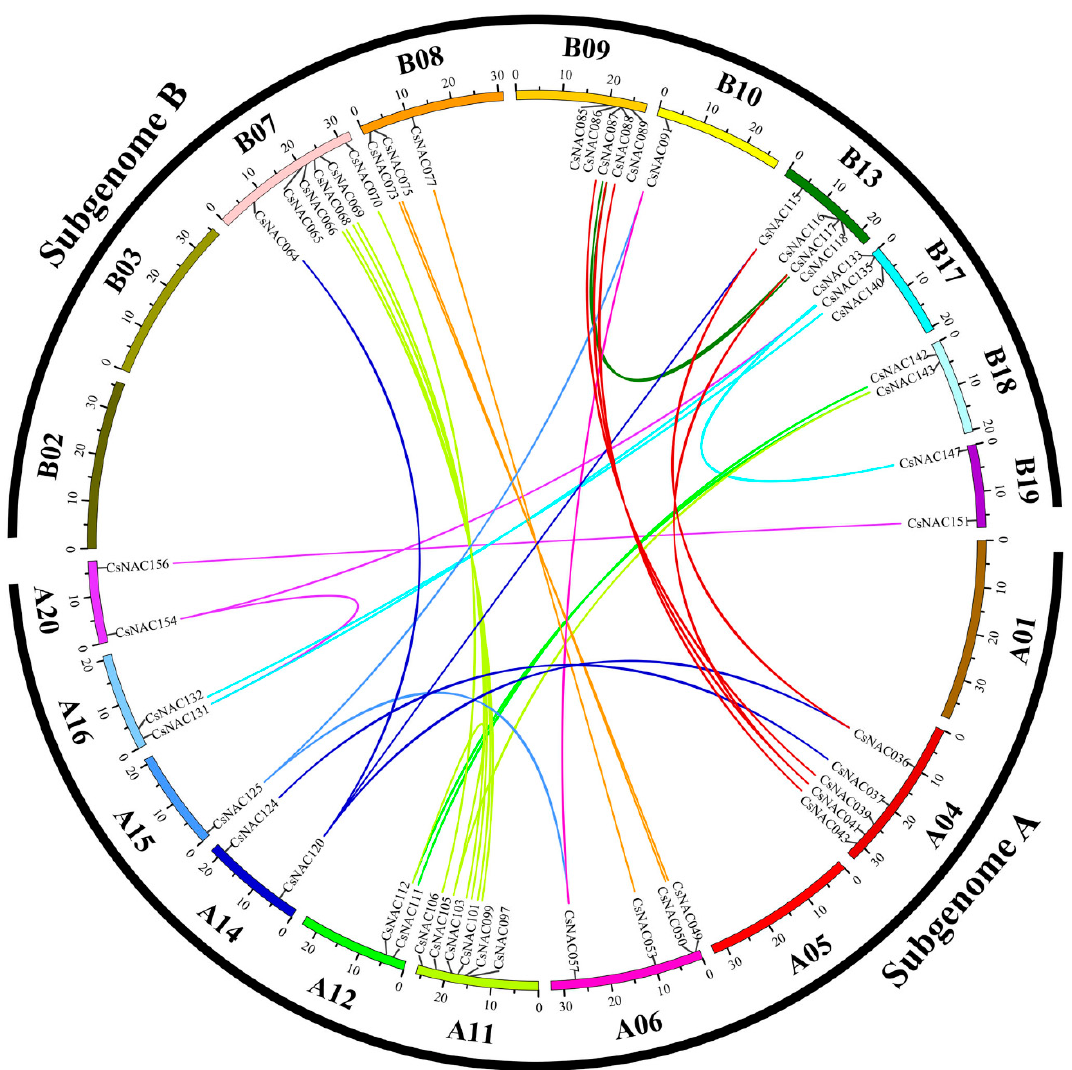
Figure 4. Phylogenetic relationships, gene structure and putative conserved domain distributions of the CsNAC family. ( a ) The phylogenetic tree was constructed with CsNAC protein sequences using MEGA 7 software. The cluster details are indicated in multiple colors. ( b ) Exon–intron structure is indicated by red rectangles and black lines, respectively. ( c ) Multiple colored boxes represent different motifs. The motif sequence information is provided in Figure S1.